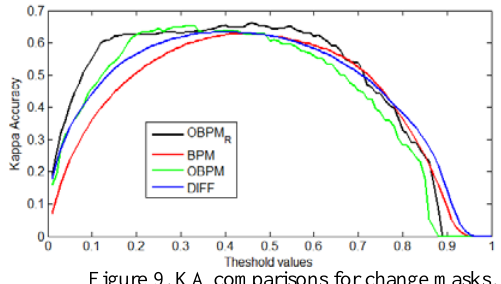
Figure 9. KA comparisons for change masks.